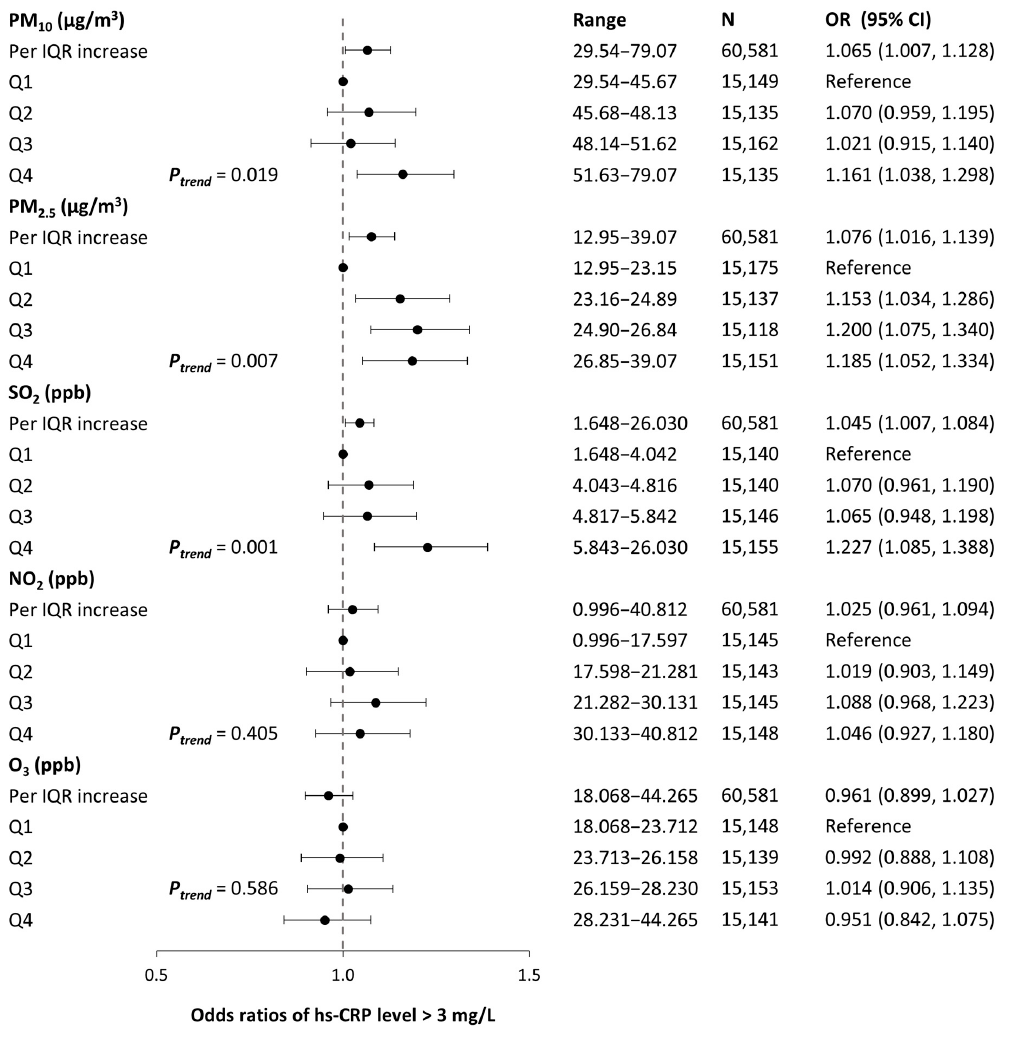
Figure 3. Associations between systemic low-grade inflammation and long-term exposure to air pollutants. The models are adjusted for age, sex, BMI, smoking status, drinking status, regular exercise, occupation, education, marital status, residential area, year, season, and weekday of exami- nation, medical history of diseases (diabetes, hypertension, dyslipidemia, cardio- and cerebrovascular disease, and cancer), and meteorological factors (2-day moving average of temperature and relative humidity). Estimates are reported as the odds ratios and 95% confidence intervals of low-grade inflammation (hs-CRP levels > 3 mg/L) per IQR increase in 2-year average ambient air pollution exposure (corresponding IQR of each pollutant: 5.95 µ g/m 3 for PM 10 , 3.70 µ g/m 3 for PM 2.5 , 1.80 ppb for SO 2 , 12.54 ppb for NO 2 , and 4.52 ppb for O 3 ). PM 10 , PM 2.5 : particulate matter with aerody- namic diameter < 10 µ m and <2.5 µ m, respectively; SO 2 : sulfur dioxide; NO 2 : nitrogen dioxide; O 3 : ozone; OR: odds ratio; IQR: interquartile range; Q1, Q2, Q3, Q4: first, second, third, and fourth quartile,